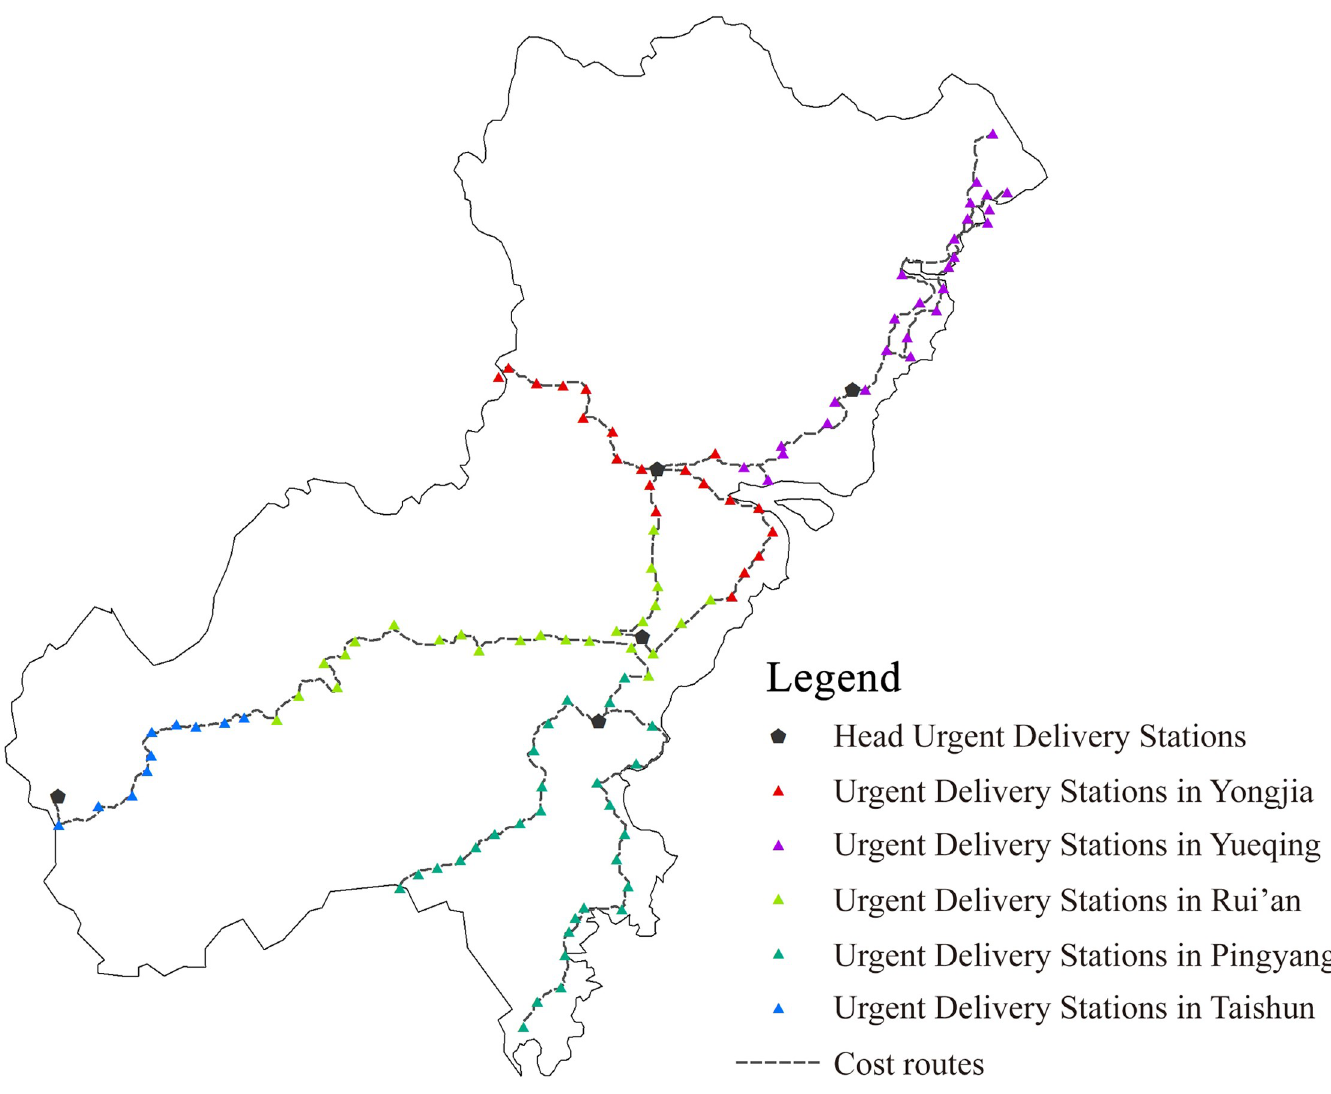
Fig 6. Cost routes of the urgent delivery